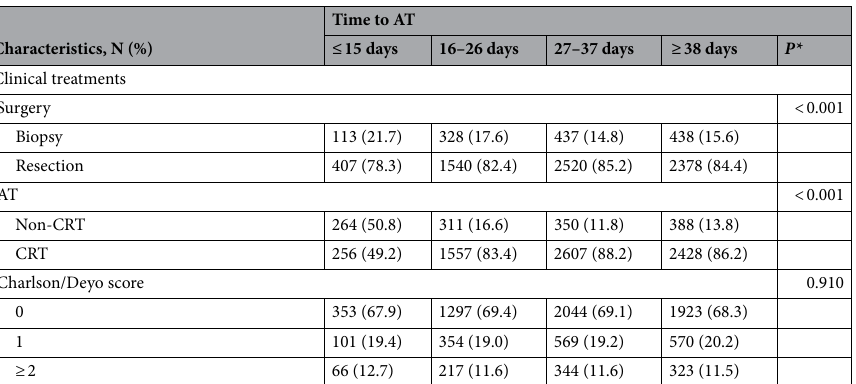
Table 2. Patient characteristics in NCDB analytic cohort by time to AT (N = 8161). AT adjuvant therapy, AC academic center, INCP integrated network cancer programs, RT radiation therapy, CRT chemoradiation, TMZ temozolomide, NA not available, was presented once the number of patients in a specific cell was 11 or less based on privacy policy of NCDB. *Pearson’s χ 2 test or Mann–Whitney U test were conducted to compare the proportions of baseline characteristics across time to